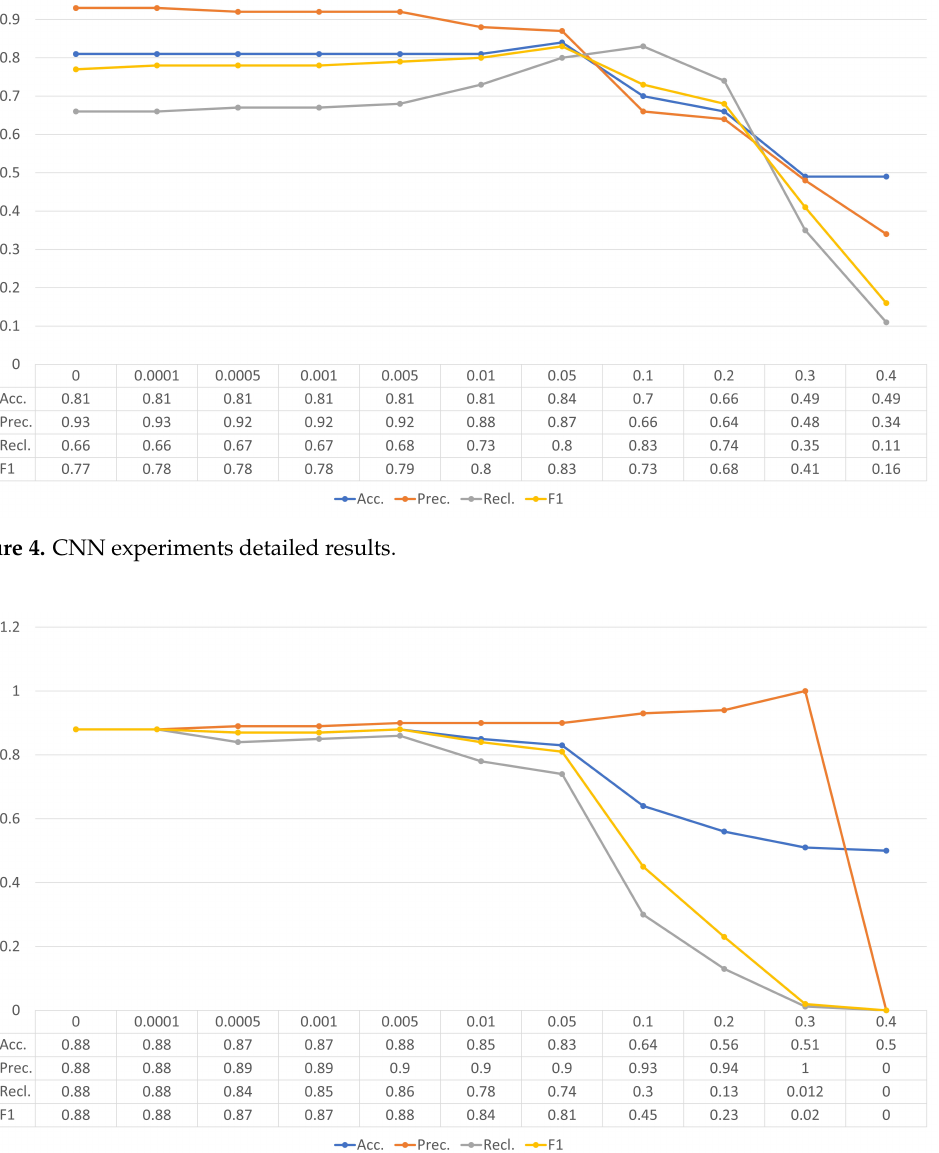
Figure 5. CRNN experiments detailed